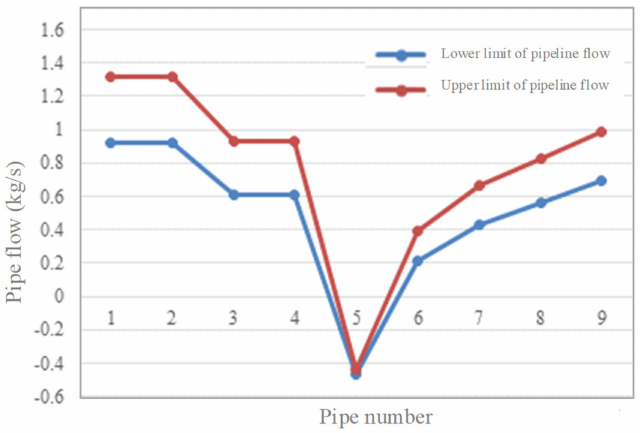
Figure 6. Pipeline flow in thermal system with uncertainty considered under high